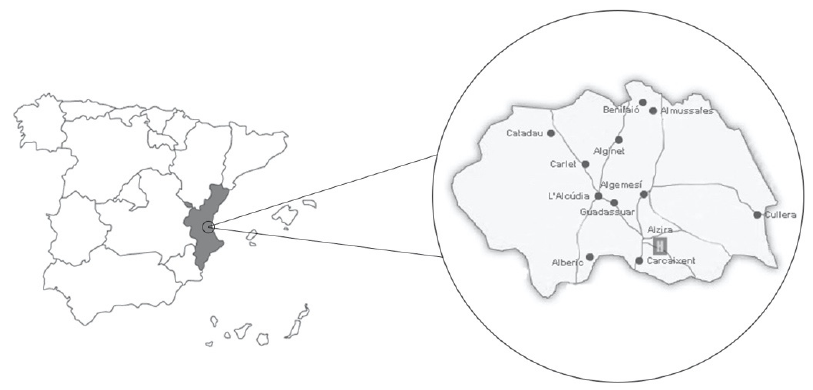
Figure 1. Study region. Source: own elaboration.